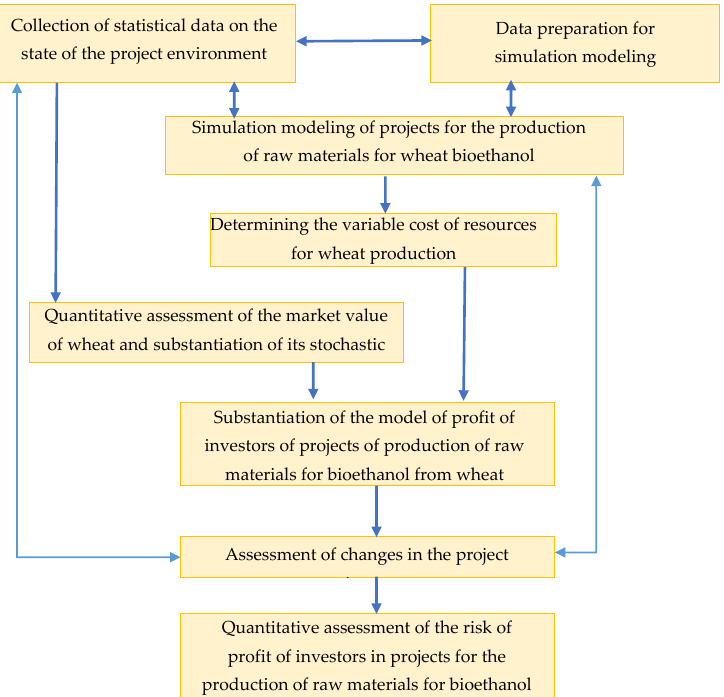
Figure 1. Stages of the proposed approach to quantitative assessment of the risk of profit of investors in projects for the production of raw materials for bioethanol In order to determine the variable costs of resources for the implementation of projects for the production of raw materials for bioethanol, a well-known simulation model is used [21]. This model represents the performance of works in these projects, taking into account the characteristics of production conditions of the project environment (field area and projected wheat yield, distance of delivery of resources for growing wheat, etc.) and predicted climatic conditions of the region (precipitation, air temperature, humidity, wind speed, etc. that determine the changing content and timing of work in projects). This stage of research provides determination of variable durations of performance of works and expenses of resources for their performance, namely: 1) need and duration of the use of equipment; 2) daily volume of performed work and duration of the use of equipment and human resources; 3) the amount of resource costs and consumables. The obtained quantitative values of variable durations of work and resource costs for their implementation are the basis for determining the amount of investments i V in these projects, taking into account the available resources and the characteristics of their project environment. In particular, by performing simulation modeling of raw material production projects for bioethanol,